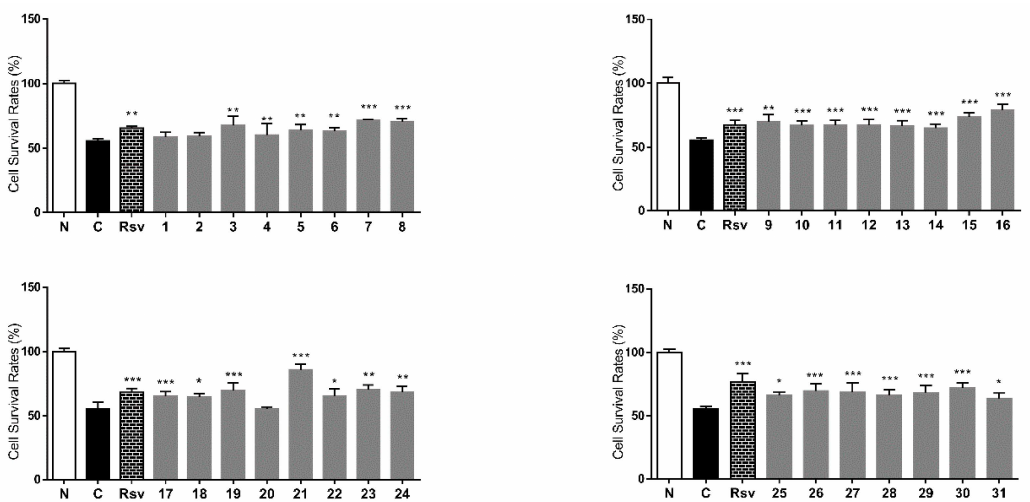
Figure 8. Cell survival rate of 1 – 31 on L6 cells treated with antimycin A. Values represent the mean ˘ SD of determinations ( n = 8). * p < 0.05; ** p < 0.01; *** p < 0.001 vs. control group. Final administrated concentration of revestrol was 10 µ M, and 1 – 31 was 30 µ M.